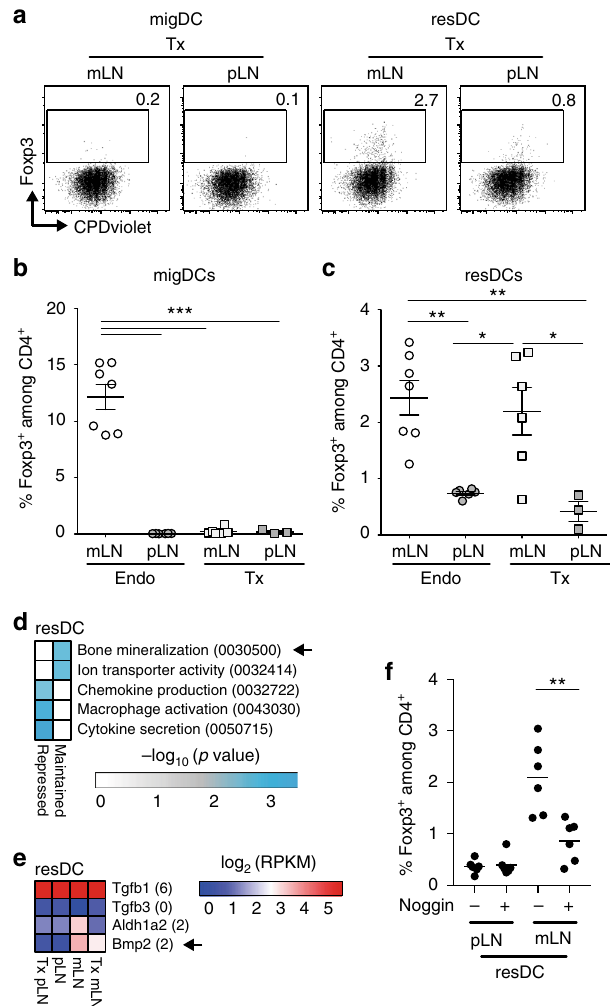
Fig. 6 mLN SCs instruct resDCs with Treg-inducing properties. Indicated LNs were transplanted to the popliteal fossa of SPF-housed mice. Eight to sixteen weeks later, single cell suspensions were generated by enzymatic digestion, and respective DC populations isolated and co-cultured with naïve CPDviolet-labeled cells isolated from Foxp3 hCD2 xRag2 − / − xDO11.10 mice and 160 ng/ml Ova 323-339 peptide for fi ve days. a Representative dotplots of Foxp3 expression over CPDviolet dilution on gated CD4 + T cells after co-culture with indicated DC subsets. Numbers indicate frequencies in gates. ( b – c ) Scatterplots show frequencies of Foxp3 + Tregs among CD4 + T cells after co-culture with migDCs ( b ) or resDCs ( c ) obtained from indicated locations. Data pooled from two to three independent experiments ( n = 3 – 7). d – e resDCs were isolated from indicated LNs. RNA-seq L and subsequent analysis was performed. d GO analysis of biological processes of genes persistently up- regulated (Maintained) or down-regulated (Repressed) in resDCs isolated from transplanted mLN-SPF. e Heatmap of expression of indicated genes. Numbers in brackets indicate average log 2 (RPKM) expression of respective genes across all experimental groups. f Scatterplots show frequencies of Foxp3 + Tregs among CD4 + T cells after co-culture with resDCs obtained from indicated locations with or without supplementation of exogenous Noggin (100 ng/ml). Data pooled from two to three independent experiments ( n = 3 – 7). migDC, migratory dendritic cell (Lin − CD11c + MHCII high ); resDC resident dendritic cell (Lin − CD11c high MHCII + ); Lin CD3 + CD45R + Ly6G + F4/80 high ,